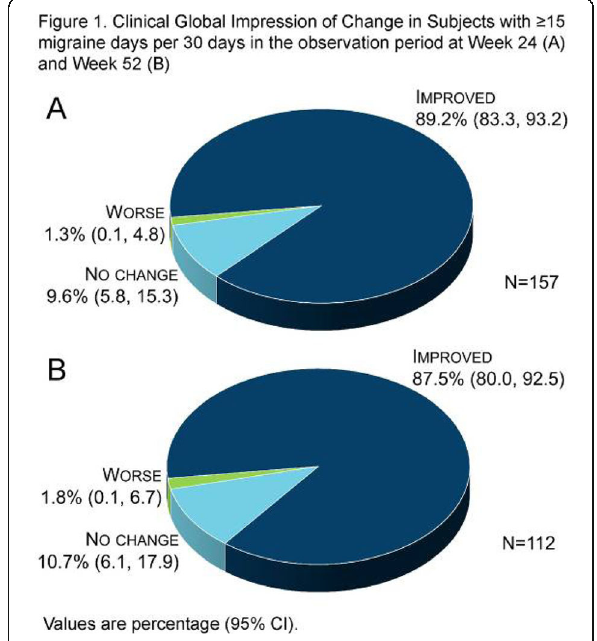
Fig. 1 (abstract P0278). See text for